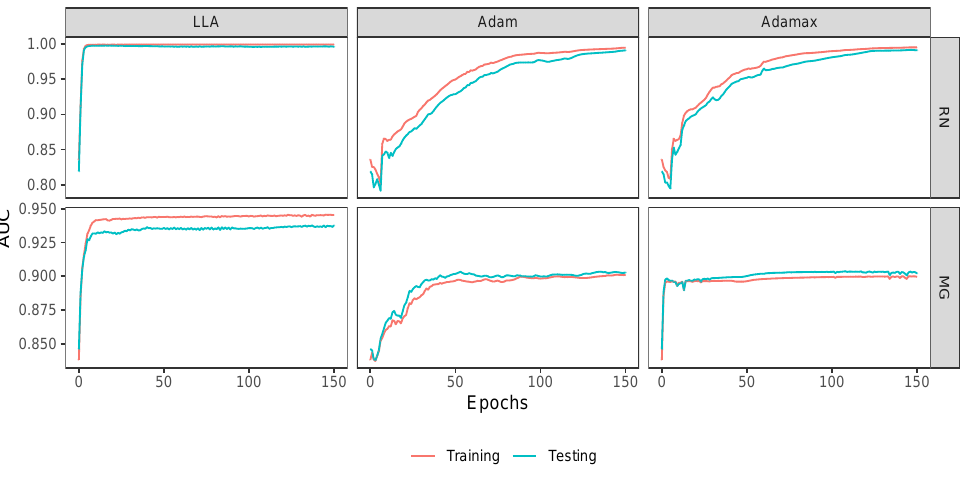
Figure 6. AUCs of LLA, Adam and Adamax algorithms versus the number of